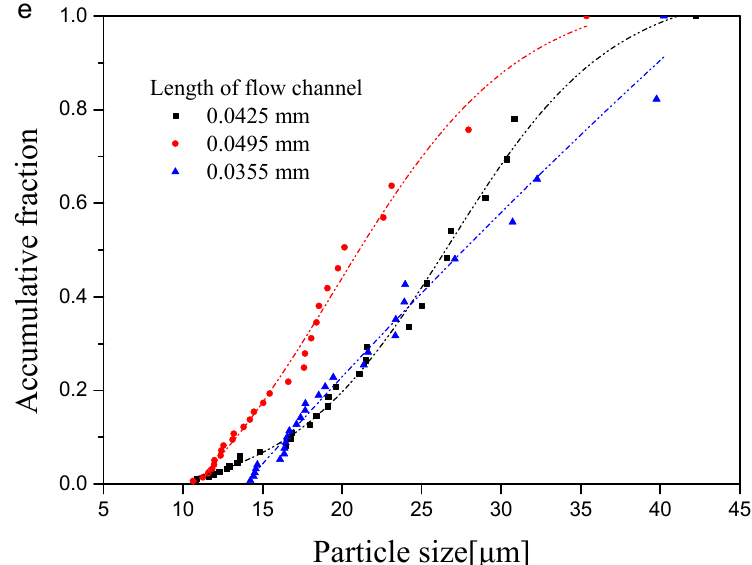
Figure 9. Comparison of ( a ) depth of the fluid channel; ( b ) atomization of the liquid phase; ( c ) spray angle; ( d ) velocity and ( e ) particle size distribution between cases 0, 5, and 6.